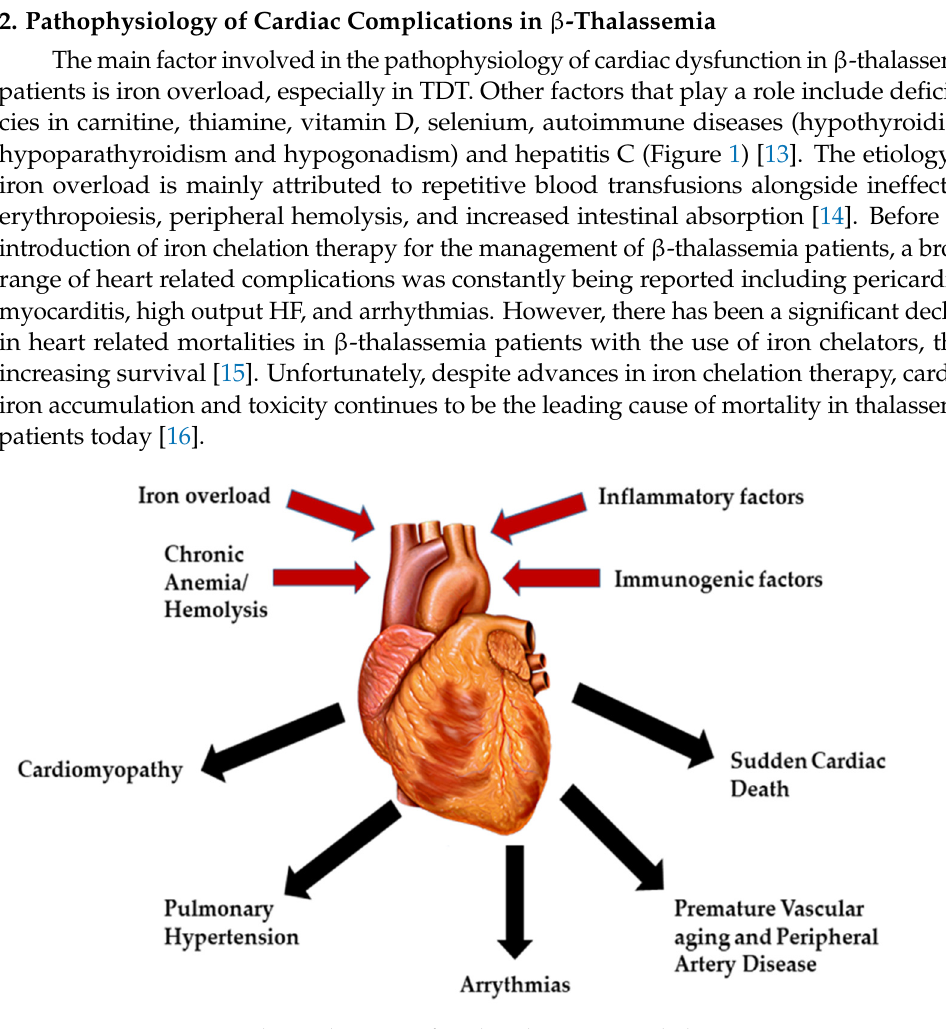
Figure 1. Major causes and complications of cardiac diseases in β -thalassemia.